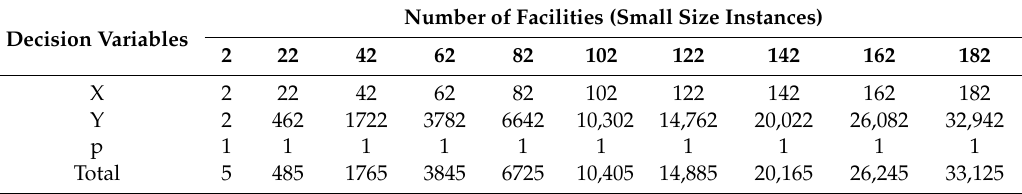
Table 8. CLITraP-HTF dimension of decision variables after applying a DRP on α